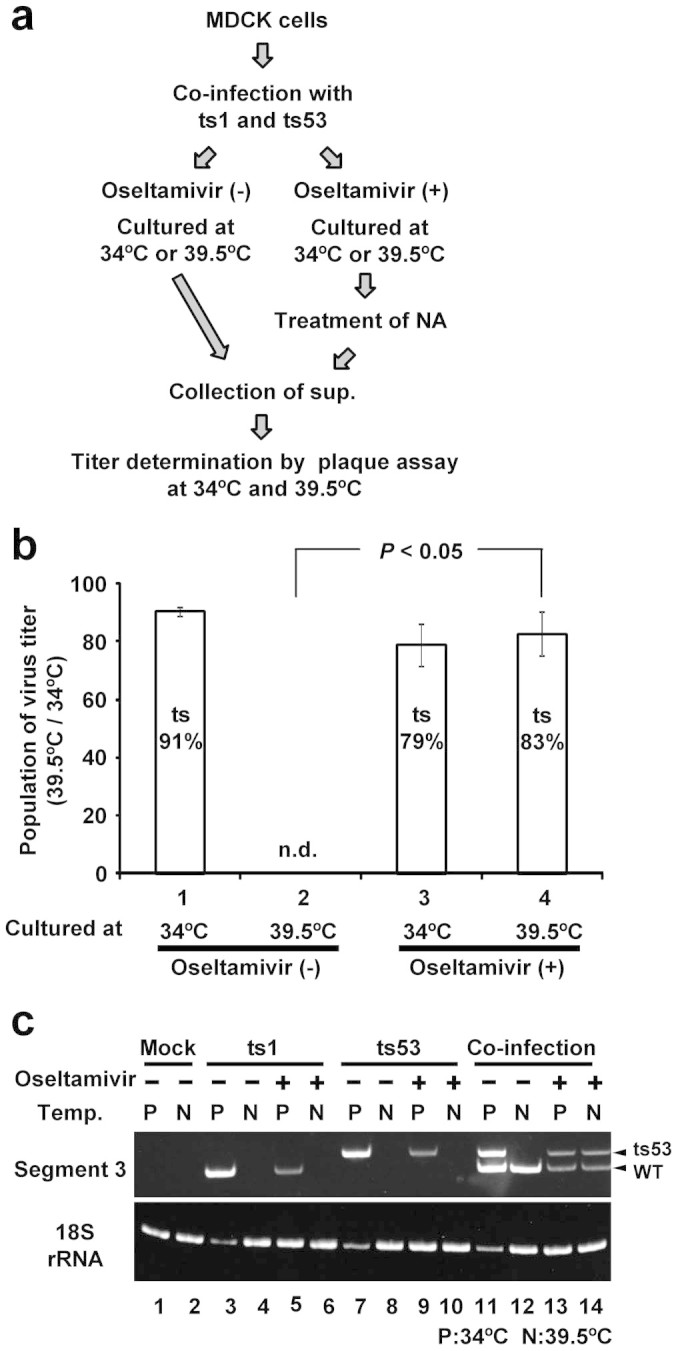
Survival of temperature sensitive mutants in the presence of oseltamivir.(a) Experimental scheme. MDCK cells were co-infected with ts1 and ts53, and then cultured at 34°C or 39.5°C in the absence or presence of 50 μg/ml of oseltamivir. Viruses grown in the presence of oseltamivir were harvested from the cell surface by treatment with bacterial NA. (b) Phenotyping by plaque assay. The culture supernatant was collected at 60 hpi, and then its virus titer was determined by plaque assays under both 34°C and 39.5°C. Population of ts mutant was calculated by the virus titer (T) represented in Table 1 using following formula, {1 − T (39.5°C)/T (34°C) c*100. The population of ts mutant treated with oseltamivir (lane 4) was compared with that of untreated one (lane 2) (P < 0.05). Error bars indicate s.d. from 3 independent experiments. (c) Genotyping by Stu I digestion. Total RNA was extracted at 40 hpi, and RT-PCR was performed using primer set for segment 3. Subsequently, the amplified DNA products were digested with Stu I and separated on 8% native-PAGE. Large and small fragments derived from ts53 and ts1, the latter of which has the same genome sequence of segment 3 as that of wild-type virus, were 220 and 199 base pairs, respectively. P and N indicate permissive temperature (34°C) and non-permissive temperature (39.5°C), respectively. The image of full length gel is represented in Supplementary Figure 2.